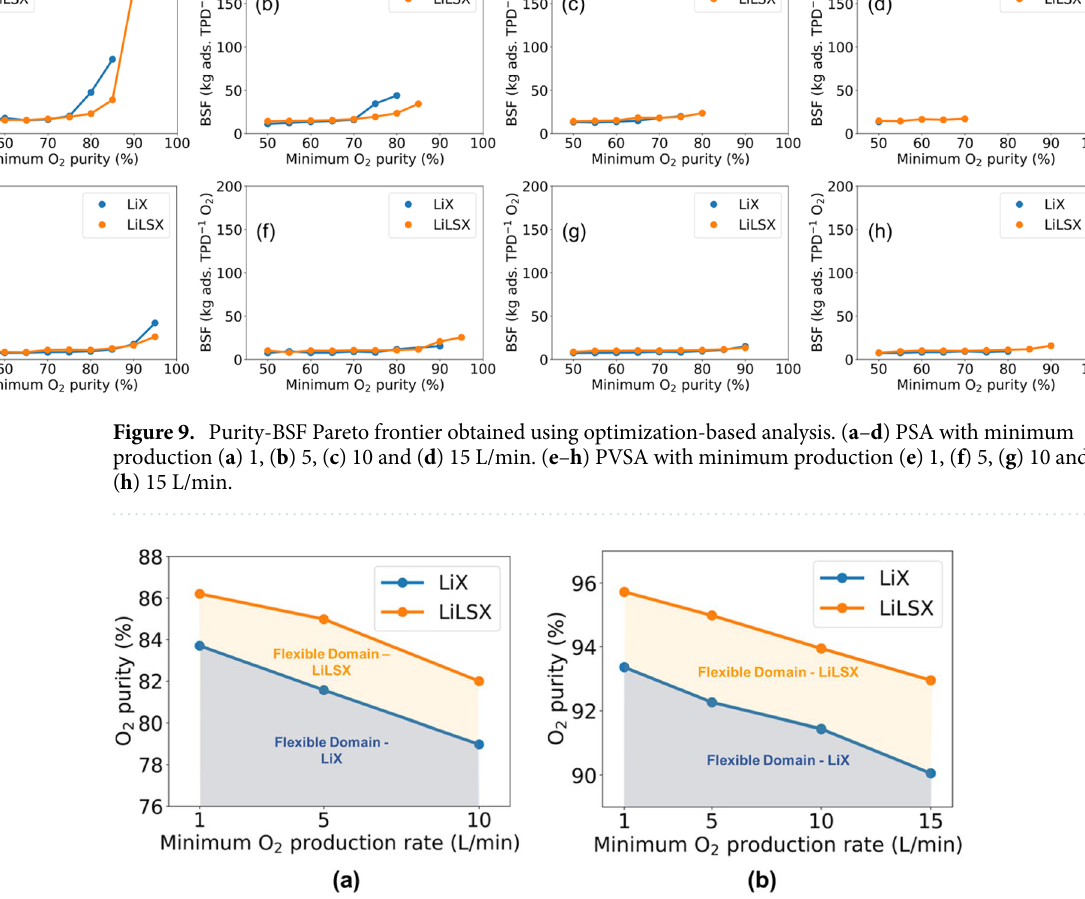
Figure 10. Flexible ( a ) PSA and ( b ) PVSA operation for generating product oxygen with different purity and production rate